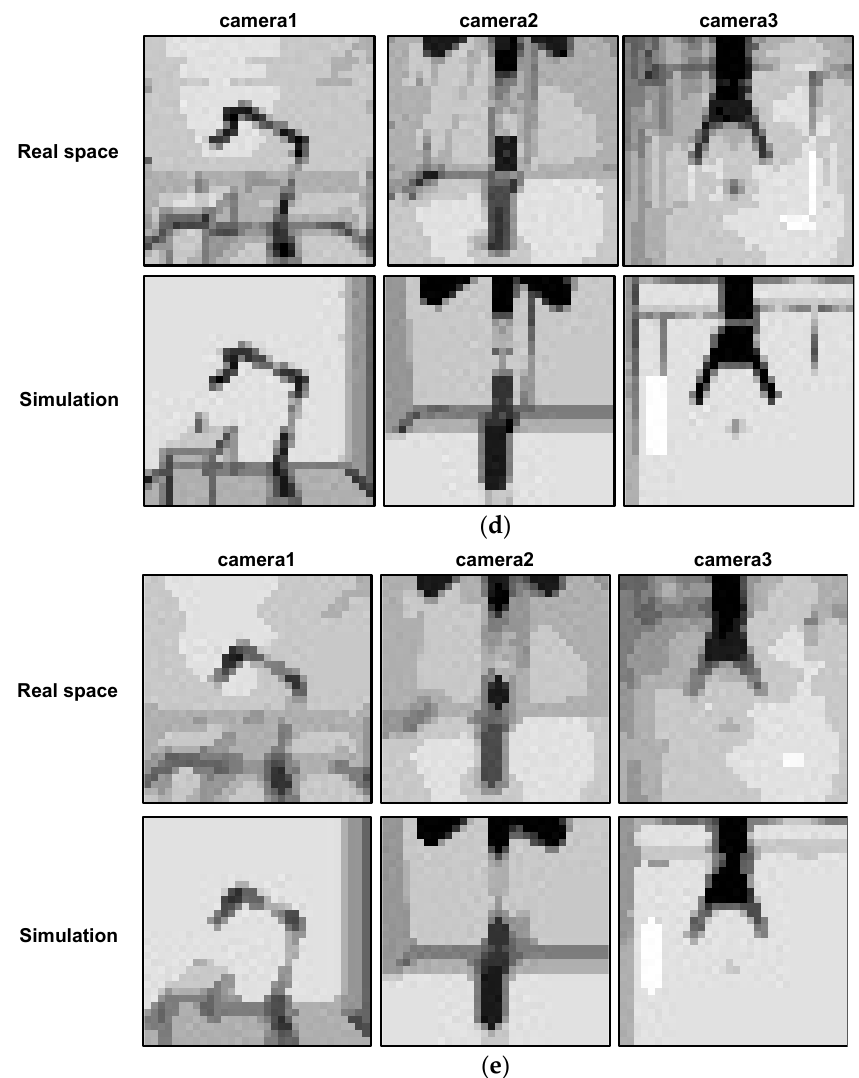
Figure 7. Sample scenes of different image processing operations adopted. ( a ) gray scale operation. ( b ) binarization operation. ( c ) 4-gradiation grayscale. ( d ) 10-gradiation grayscale. ( e ) 10-gradiation grayscale with median